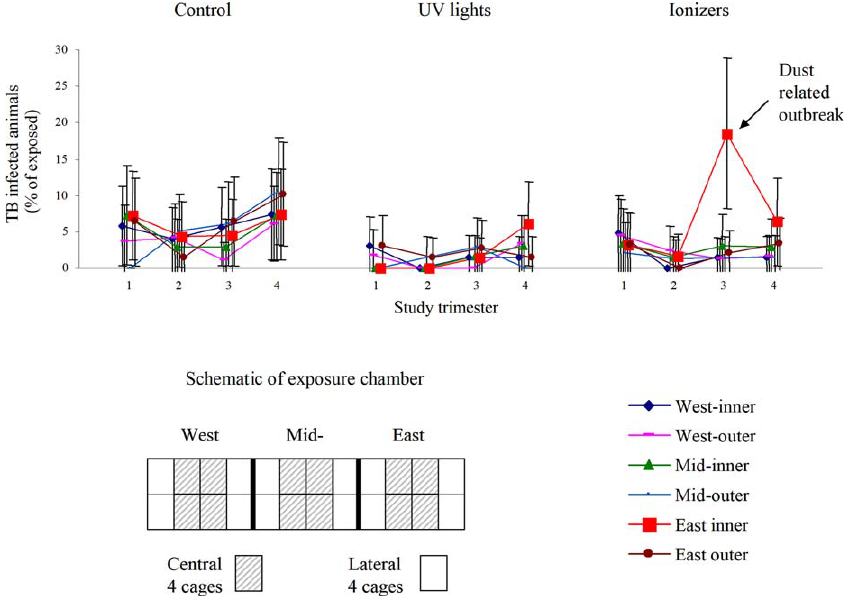
Figure 4. Distribution Over Time of TB-Infected Animals According to Cage Location Demonstrating Dust-Related TB Outbreak A schematic is shown of one of the three identical guinea pig exposure chambers, each with 24 cages arranged in two rows. Each chamber is divided into three sections (east, mid, and west). Thus each section has eight cages, four located centrally and four located laterally within each section. TB- infected animals have been grouped in 3-mo study periods (trimesters), excluding the first and last 2 mo of the study owing to small numbers as the study started and finished. The third trimester immediately followed the cleaning of an ionizer creating a dust cloud directly above the four centrally located cages in the east section of the ioniser animal enclosure. Numbers of TB-infected animals (expressed as a percentage of total numbers of animals exposed) are shown for each of the six parts of the Control, UV, and Ionizer guinea pig exposure chambers, for three-monthly study periods.